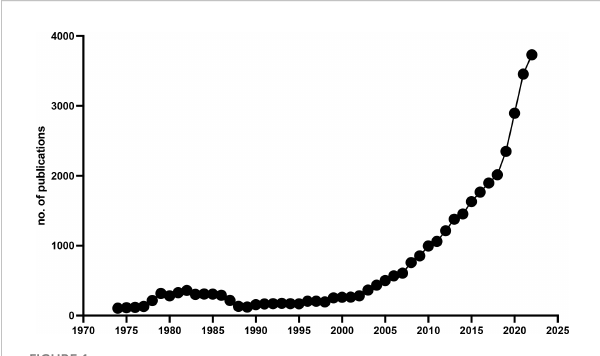
FIGURE 1 Number of neuroscience publications by authors with African institutional af fi liations. Data extracted from Scopus using as keywords neuroscience, neurology, nervous system, brain, spinal cord, and African institutional af fi